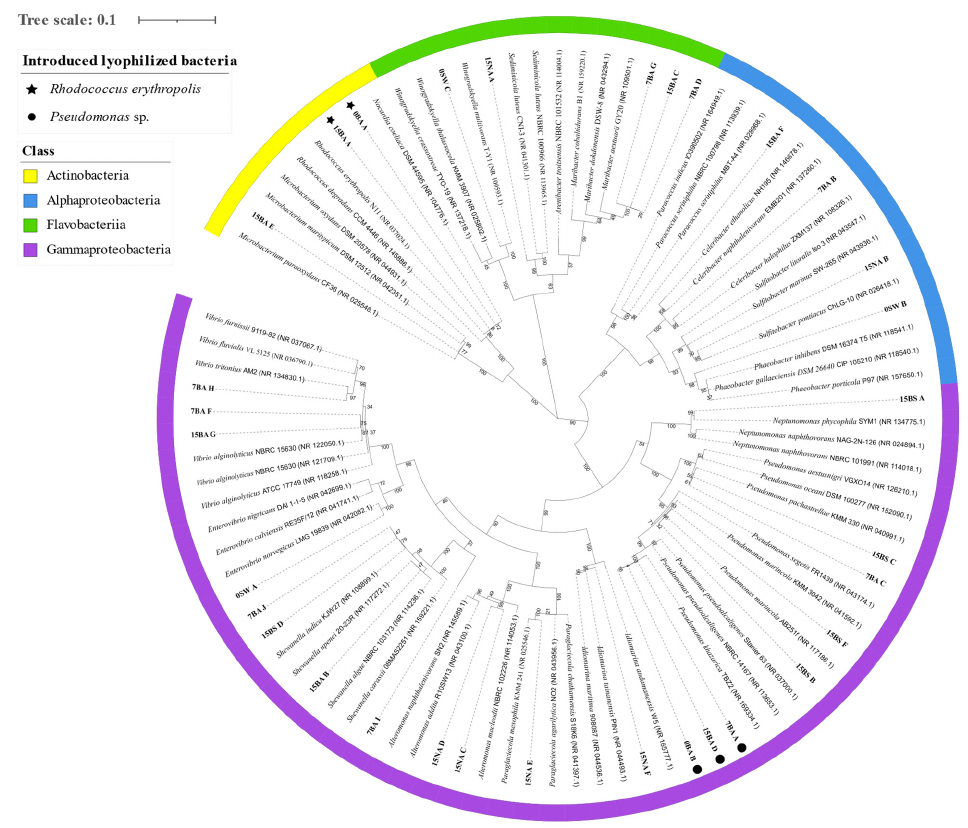
Figure 7. Phylogenetic tree of the bacterial strains isolated in the microcosm bioremediation experiment and their GenBank 3 nearest neighbors. Bacterial isolates were identified in the natural seawater (SW), in the bioaugmentation (BA) treatment at the beginning (T0), after 7 days of experiment (T7) and at the end of the experiment (after 15 days) (T15), and for natural attenuation (NA) and biostimulation (BS) treatment after 15days (T15). The maximum likelihood phylogenetic tree was performed in MEGA X using 93 nucleotide sequences, with 1410 bp length and the bootstrap method with 1000 replications. The tree is drawn to scale, with branch lengths measured in the number of substitutions per site. The GenBank accession numbers are indicated in parenthesis.